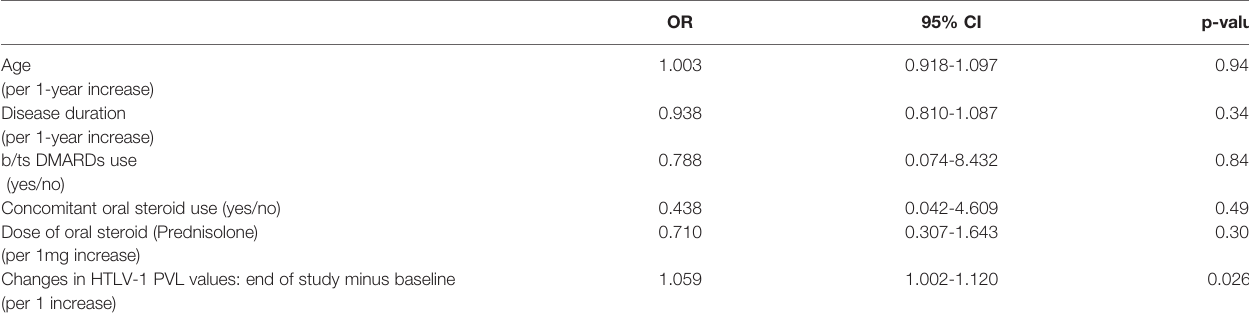
TABLE 4 | Univariate analysis for correlates of incidence of